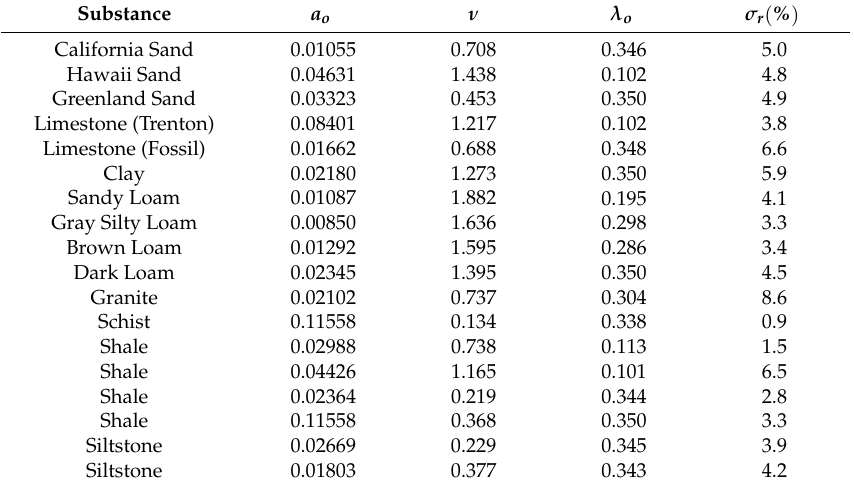
Table 4. This is a table of the functional fits to various minerals according to the formula.